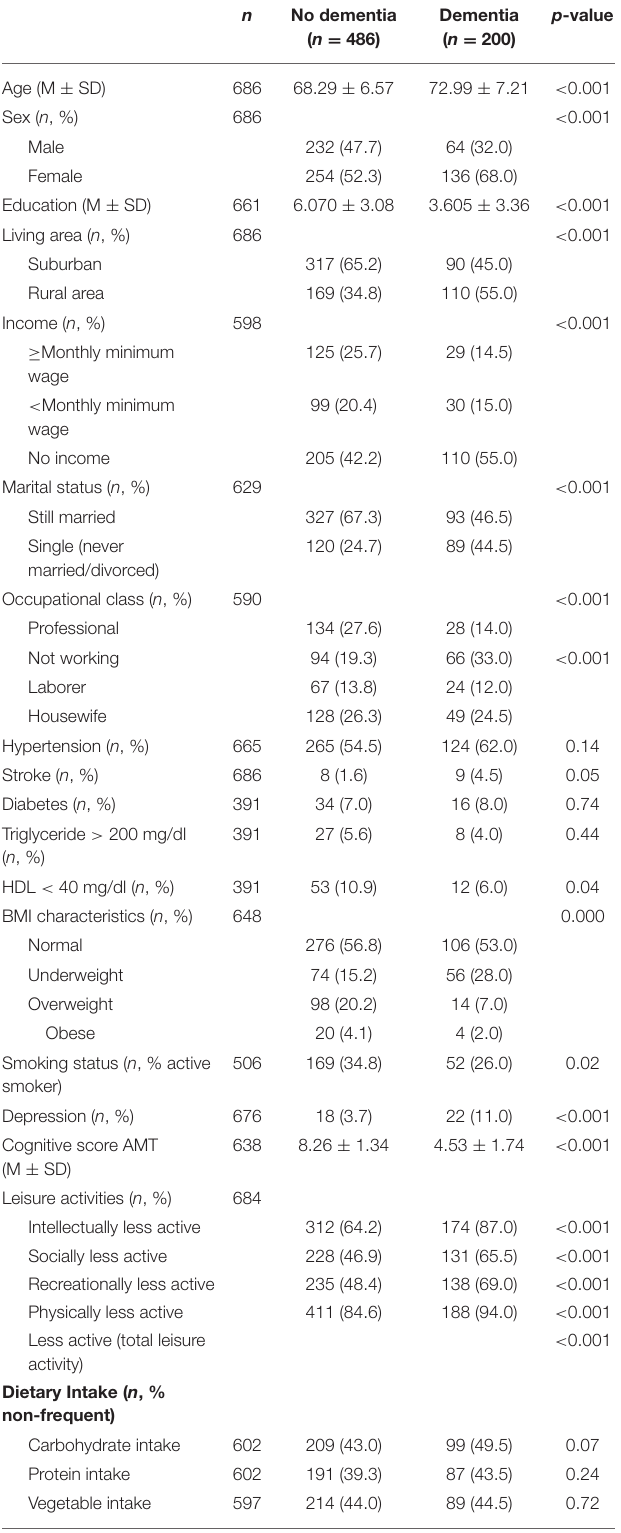
TABLE 1 | Baseline characteristics of participants with and without dementia in Jatinangor cross-sectional study ( n = 686).